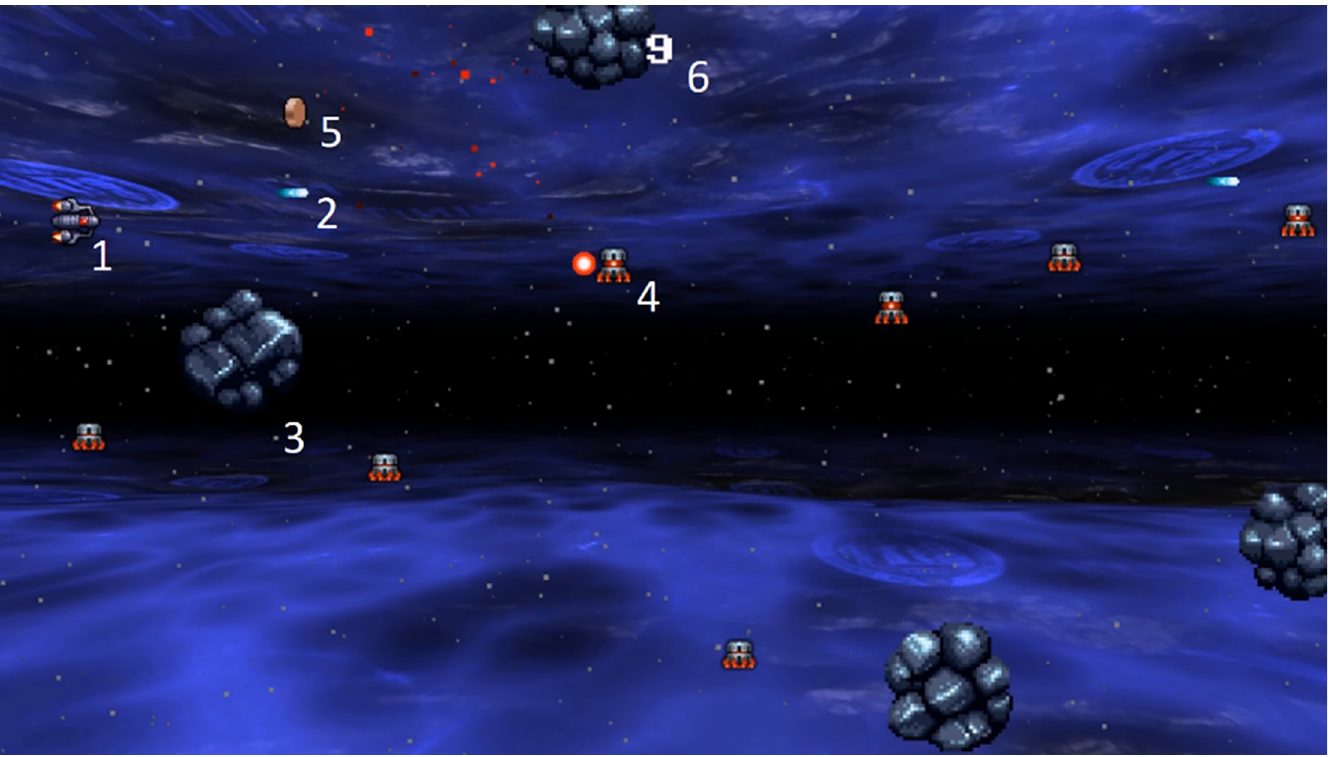
Fig 1. “Side-scroller” game where the player navigates a spaceship (1) that shoots (2). The main goal is to avoid a collision with objects (3) and other spaceships (4), which also shoot bullets. Special objects (5) can be collected to gain more power. Destroyed objects earn points (6).